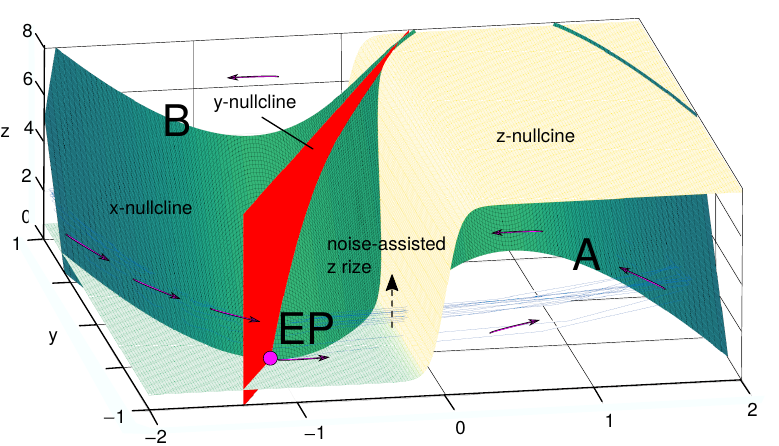
Figure 6. The 3D nullcline plot for the reduced model. Volume variables are fixed at initial values, and astrocytic potassium reuptake is blocked. Green, red and yellow surfaces show x, y and z nullclines, respectively. Thin curves in the bottom part show the exemplary noise-driven